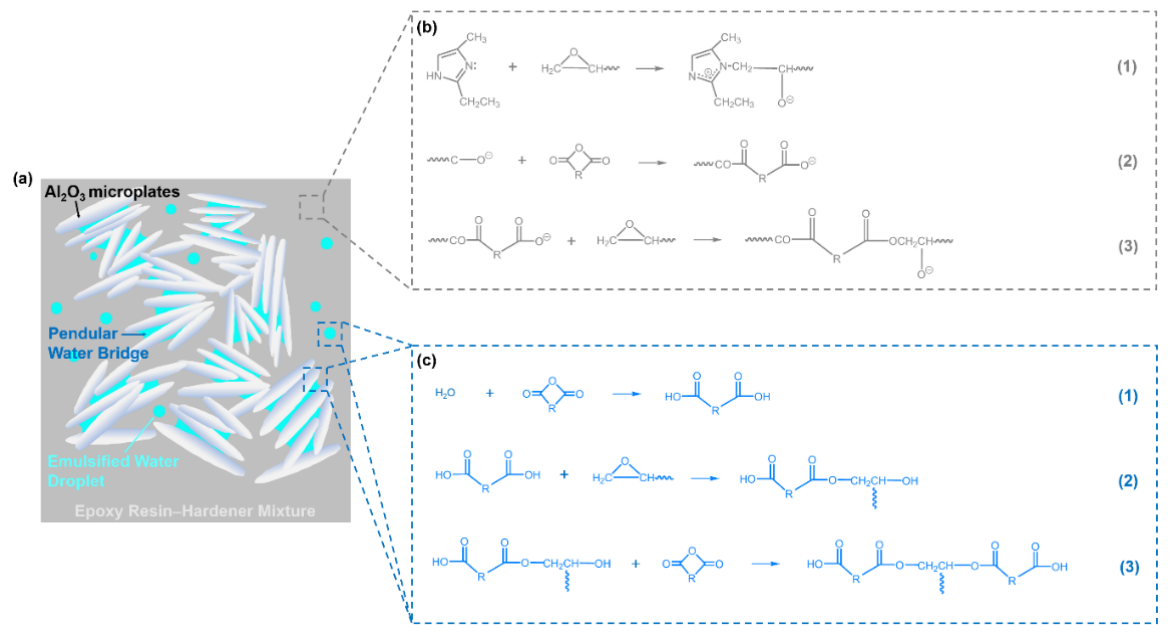
Figure 5. ( a ) Schematic of epoxy – alumina composite ink with added water. Proposed mechanisms of epoxy – anhydride curing reactions initiated by ( b ) EMI [28] and ( c ) water [29].